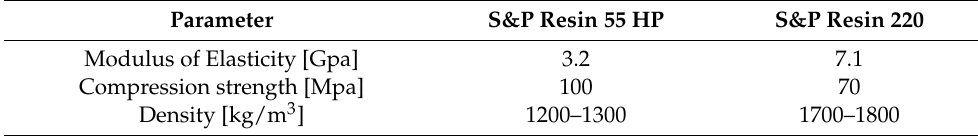
Table 3. Mechanical and physical parameters of adhesive (exposed by manufacturer) [44,45].